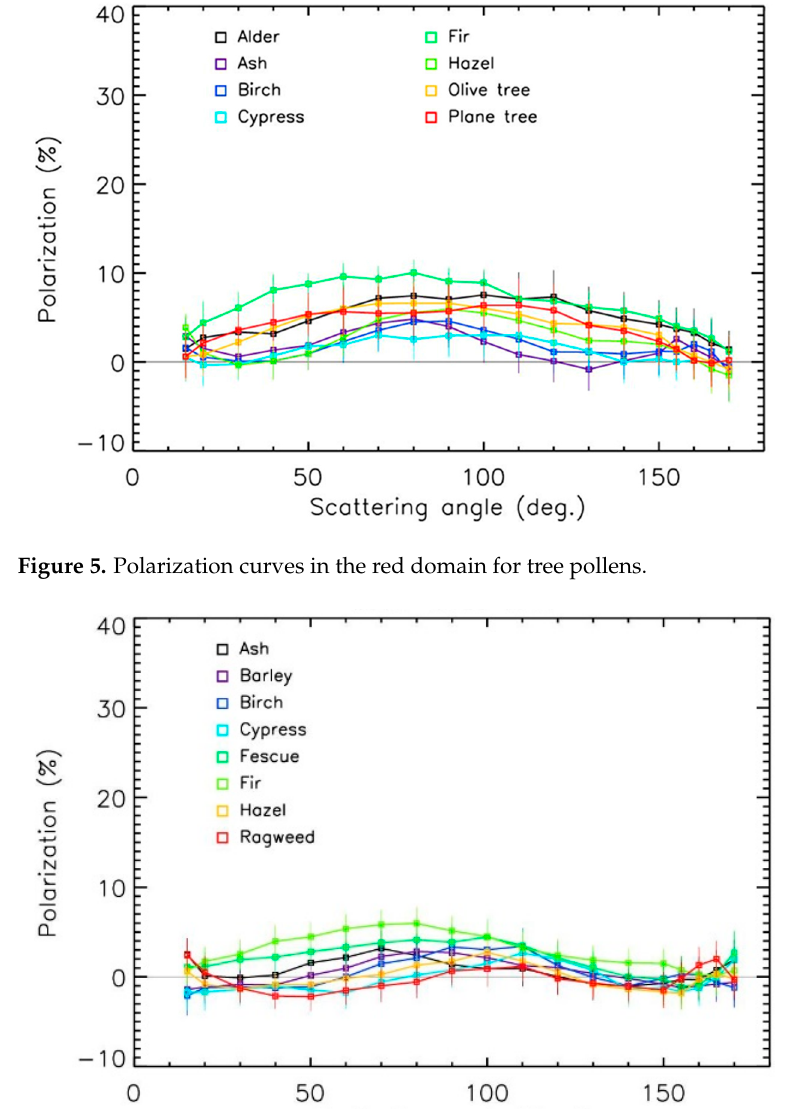
Figure 6. Polarization curves in the green domain.